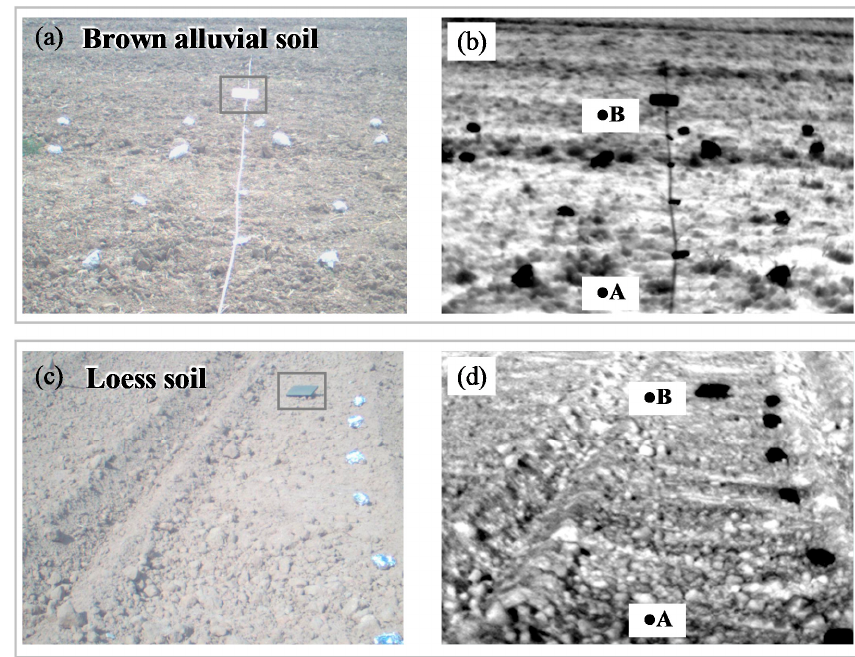
Figure 2. ( a ) and ( c ) RGB images of the two study areas; gold plate (gray square) and aluminum foil signs (delimiting 1-m 2 regions in which dust-like materials were dispersed) were placed in each area. ( b ) and ( d ) Respective LWIR images (band 10.62 µm); the sensor was located at a distance of 3 and 8